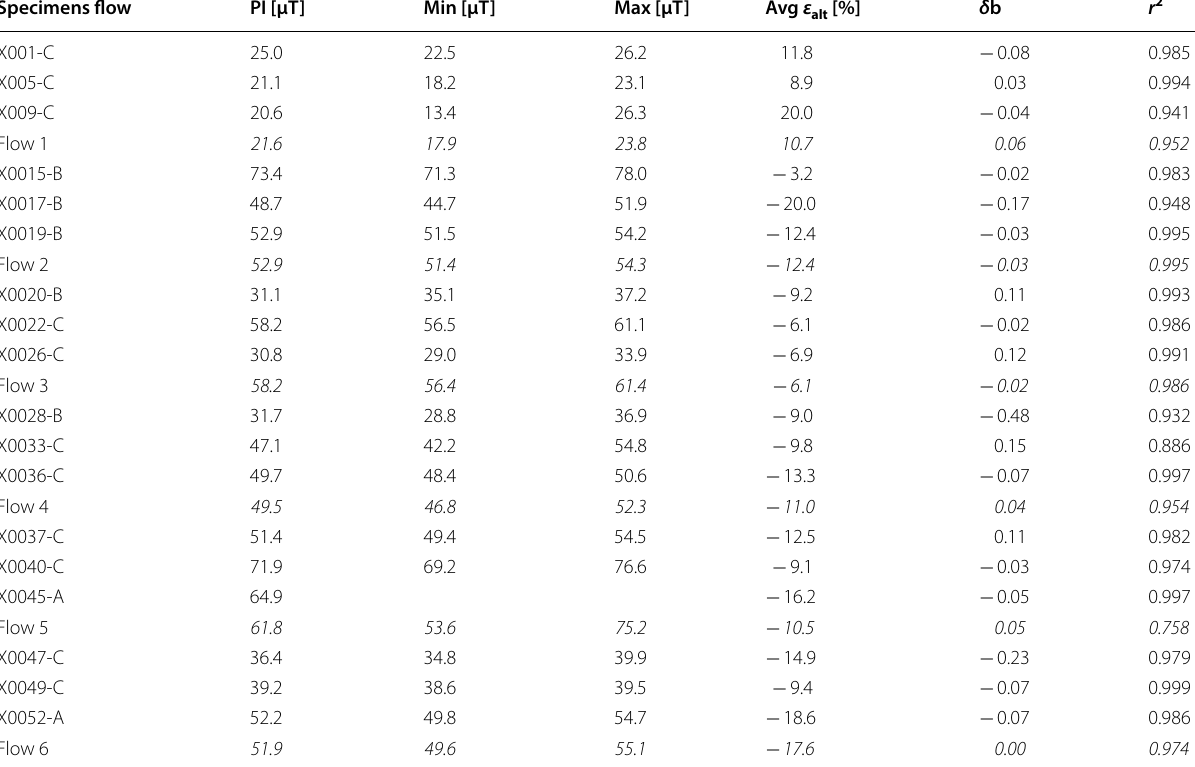
Table 3 Multi‑specimen ( Q ) paleointensity results for the different flows studied. Min and Max: estimated minimum DSC and maximum paleointensity